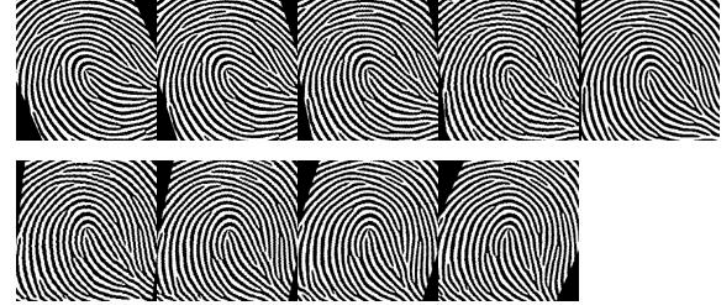
Figure 3. Generating a training set of one fingerprint.